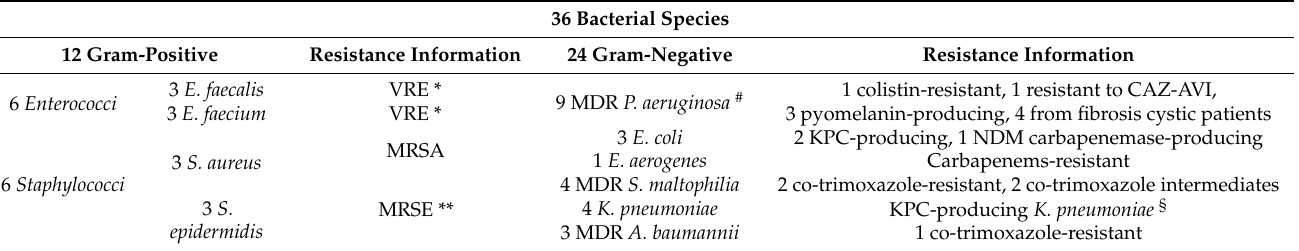
Table 1. Bacterial species considered in this